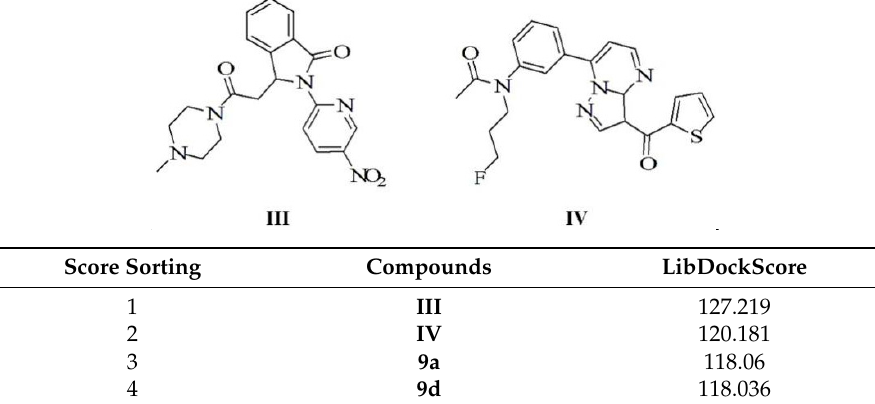
Table 4. Docking results of compounds 9a , 9d , III, and IV by the protocol of LibDock.